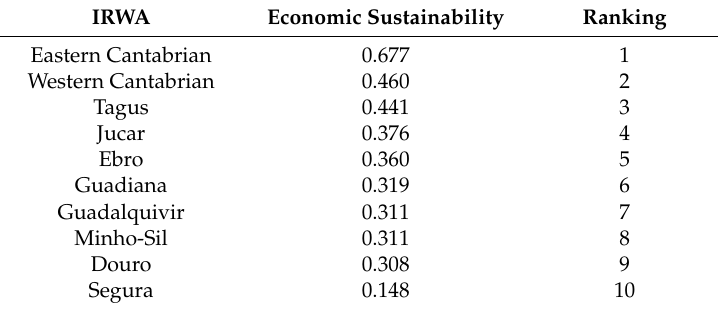
Table 6. Economic sustainability of IWBA.